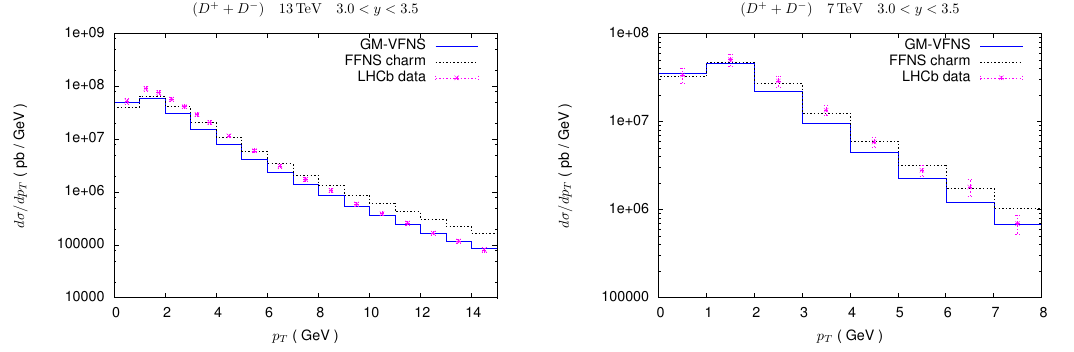
Figure 5 . Our GM-VFNS predictions for ( D + + D (cid:0) ) transverse-momentum distributions com- pared to the FFNS calculation of charm hadroproduction multiplied with the branching fraction for c D + and D (cid:0) (see text for explanation). The (cid:12)gure refers to the 3 < y < 3 : 5 rapidity bin ! with p S = 13 TeV (left) and 7 TeV